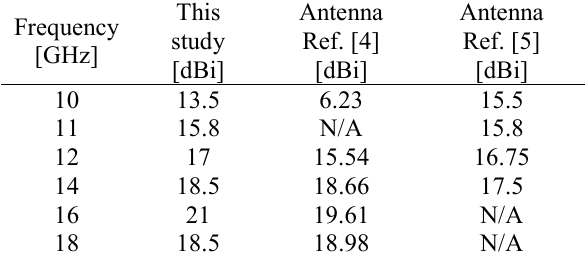
Table 4: Comparison of measured gain values.